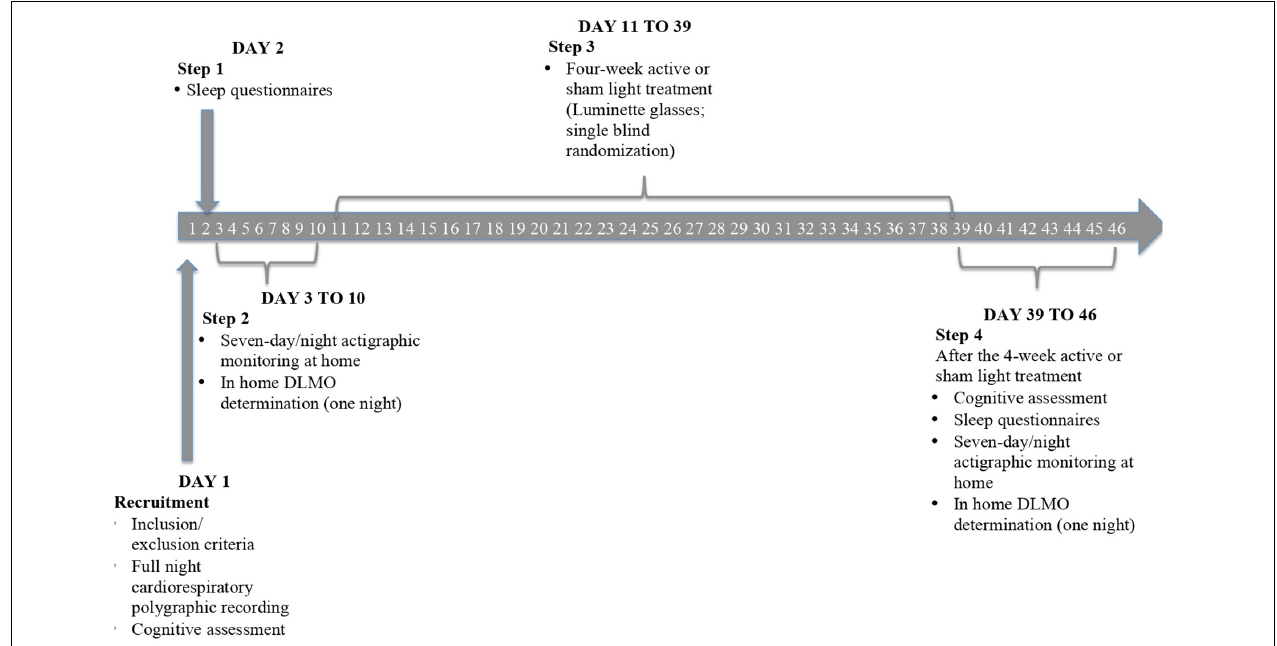
FIGURE 1 | Progressive steps of the study protocol. After the recruitment, all the patients once checked for clinical exclusion criteria, performed a full night cardiorespiratory polygraphic recording, and received the first battery of neuropsychological tests [i.e., Mini-Mental State Examination (MMSE) and Neuropsychiatric Inventory (NPI)] with the addition of Beck’s Depression Inventory. Subsequently, they filled out sleep questionnaires [i.e., Pittsburgh Sleep Quality Index (PSQI) and Epworth Sleepiness Scale (ESS)] under medical supervision. The following step consisted of a 7-day/night actigraphic monitoring through a triaxial actigraphic watch (MotionWatch8), assessing the 24-h activity-rest rhythm and objective sleep parameters of subjects. Salivary melatonin collection was then performed to determine the circadian phase of patients by means of dim light melatonin onset (DLMO). These data permitted us to plan a 4-week tailored light (active or sham) exposure by means of Luminette glasses. At the end of the protocol, we reassessed cognitive, sleep, and circadian measures to evaluate a potentially favorable effect of light